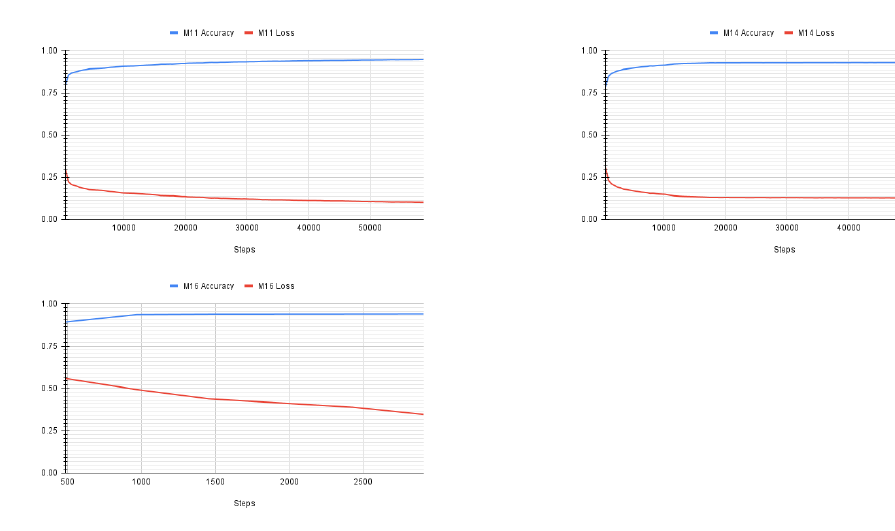
Figure 5. Potsdam test dataset semantic segmentation output of model M-16* with center cropped predictions. White : Impervious surfaces, Blue : Building, Cyan : Low vegetation, Green : Tree, Yellow : Car, Red : Clutter/background.